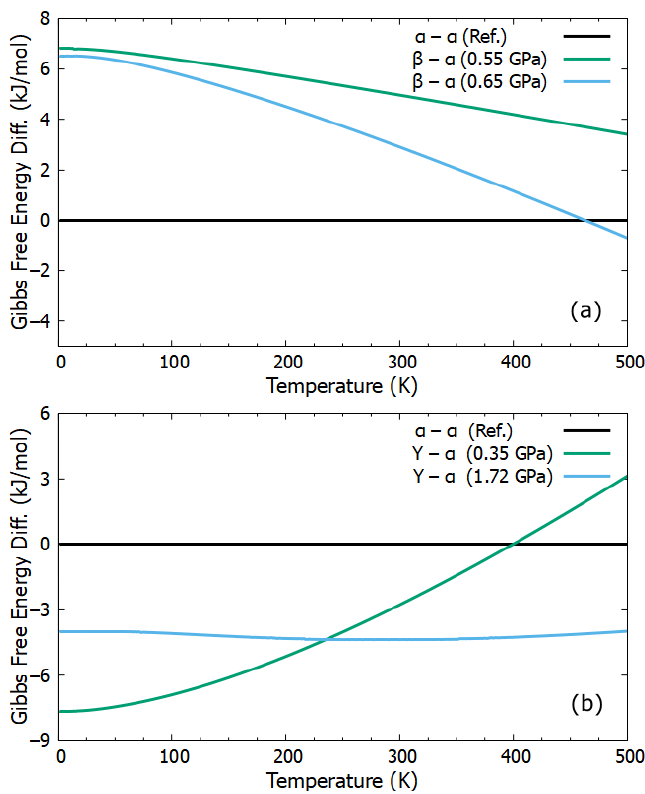
Figure 3. The calculated Gibbs free energy differences concerning temperature and different pressures. ( a ) Shows Gibbs free energy differences between phases α and β . ( b ) Shows Gibbs free energy differences between phases α and γ